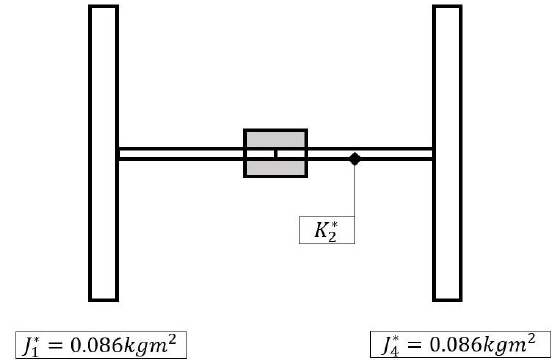
Figure 8. Schematic representation of the reduced model using Rivin’s algorithm [16] for the analytical calculation of the first torsional